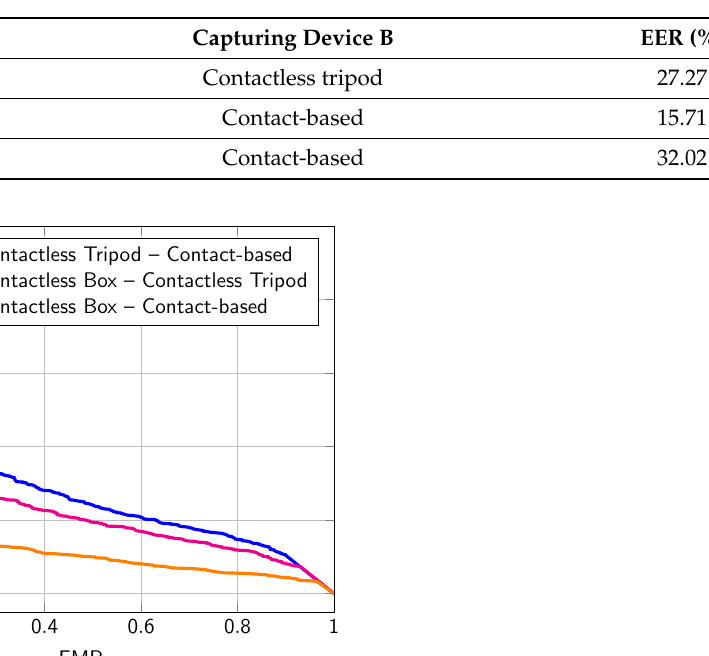
Table 7. Overview of the interoperability of different subset of the collected data: Comparison of fingerprints captured with different setups. All captured fingers (finger-IDs 2–5 and 7–10) are considered.